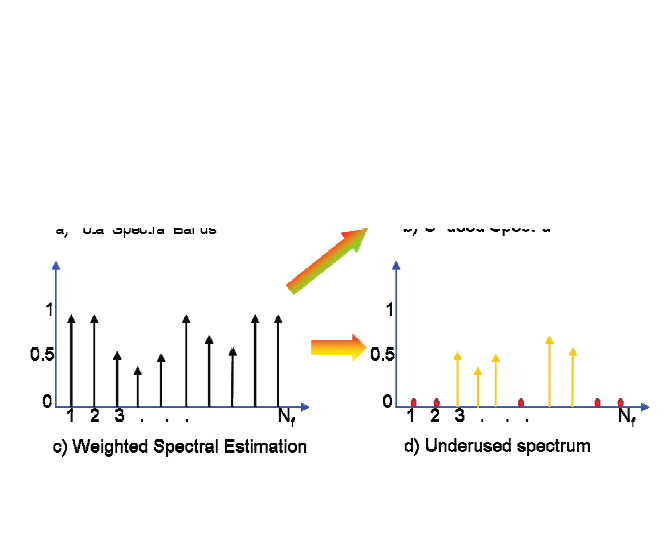
Figure 51. Block diagram representation of SD-SMSEframework